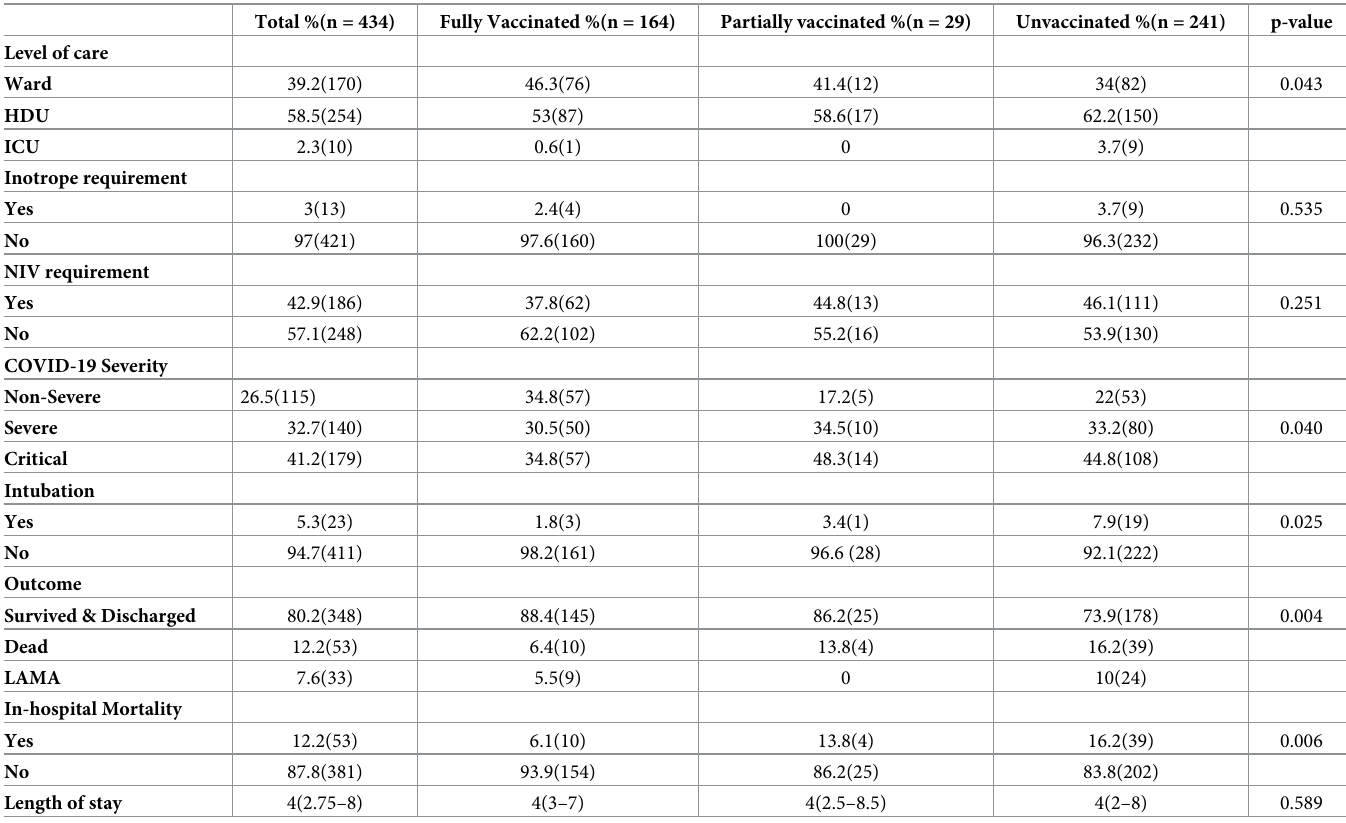
Table 6. Clinical Outcomes of COVID-19 infection in vaccinated as compared to non-vaccinated